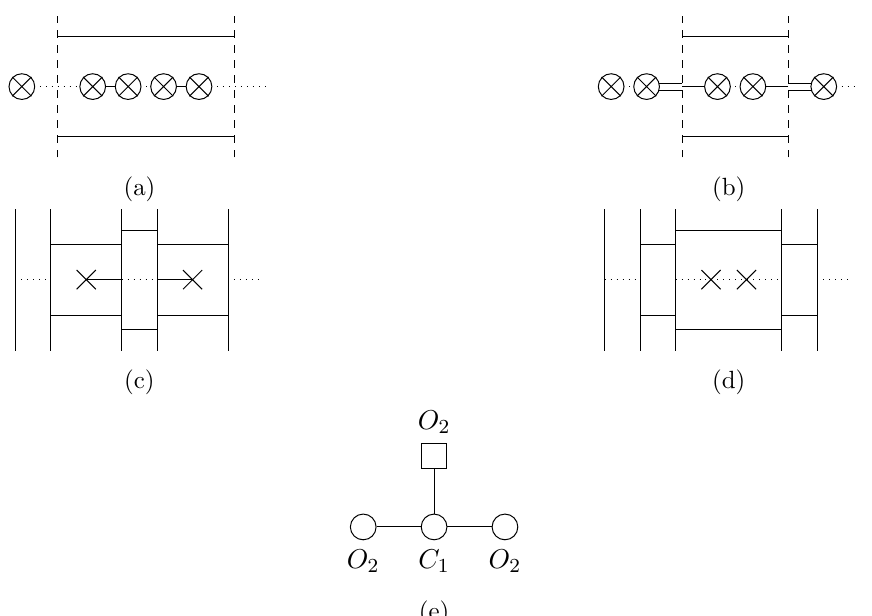
Figure 46. Transverse slice S = D 3 that can be removed via Kraft-Procesi transition. (a) Local brane con(cid:12)guration. (b) Phase transition towards the Coulomb branch brane con(cid:12)guration of the local system. (c) Coulomb branch brane con(cid:12)guration. (d) A collapse transition is performed in (c) in order to read the quiver. (e) Quiver, its Higgs branch is M H = D 3 , see the computation in appendix